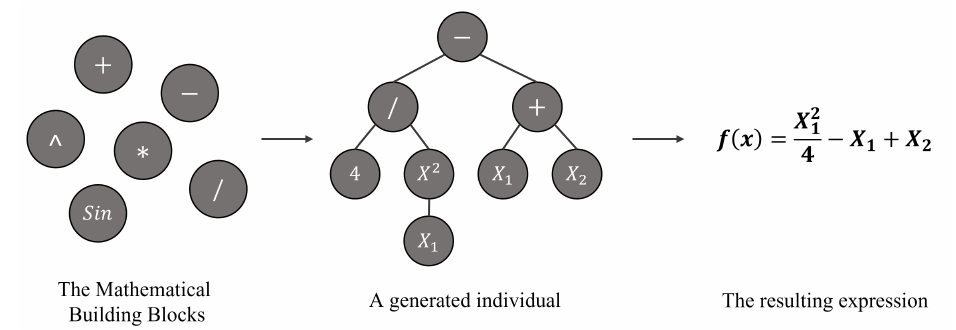
Figure 2. An illustration of a symbolic regression